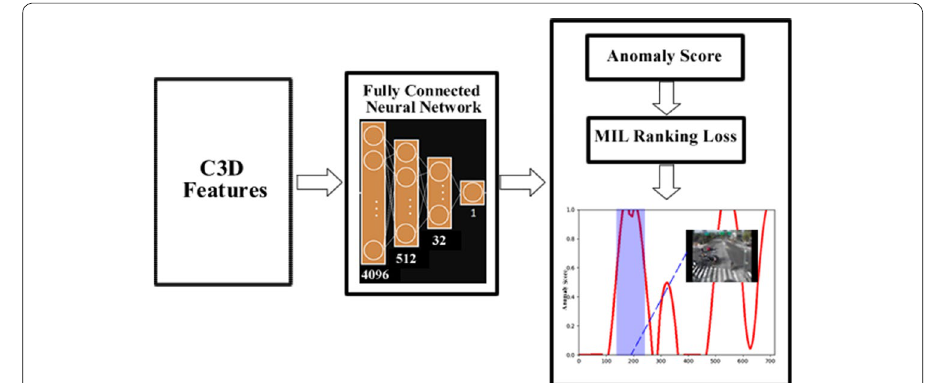
Fig. 7 Flow diagram of proposed visual attention-based anomaly detection